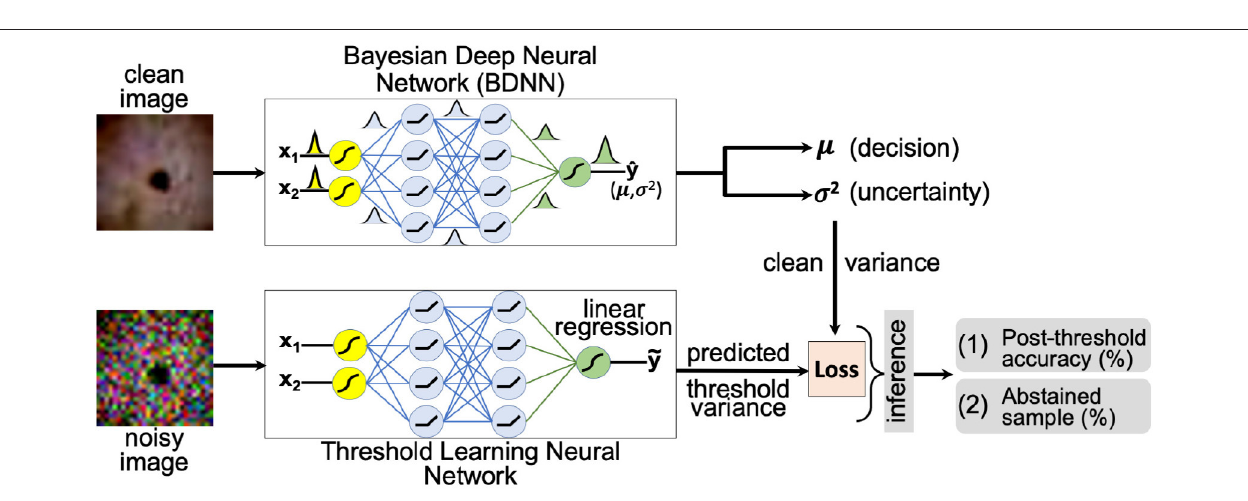
FIGURE 2 | A schematic layout of the threshold learning method is presented. The threshold variance is learned using a neural network. At the inference time, the model abstains or outputs “no decision” if the predictive variance is above the learned threshold value. The threshold is learned using both the clean and the noisy training